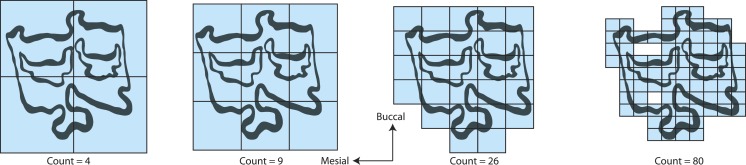
Fractal box counting method applied to a trace of the P3 of Equus asinus (MVZ 154358).The method uses a series of boxes (blue) of varying sizes to break down a convoluted linear pattern. The count of boxes for each box size and the box size (pixels) are then logged and a straight, fitted line is applied. The slope of this line is the inverse of the fractal dimensionality (D; Smith, Lange & Marks, 1996).